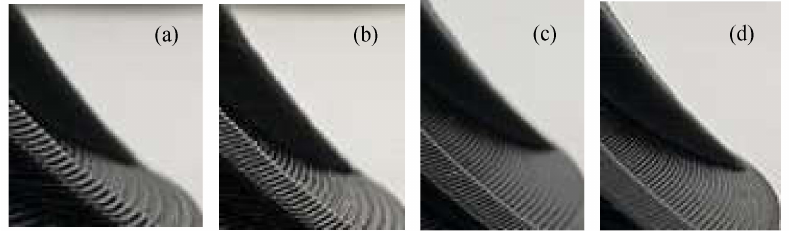
Figure 13. Partial details of turbine blade model. ( a ) Slicing thickness is 0.4 mm. ( b ) Slicing thickness is 0.3 mm. ( c ) Slicing thickness is 0.2 mm. ( d ) Partial detail of adaptive layering based on optimal volume